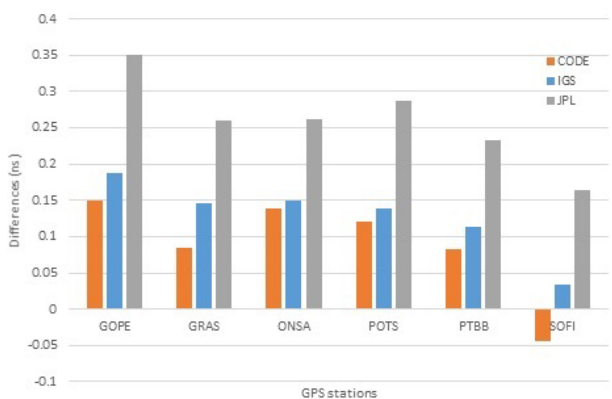
Figure 4. Mean differences between receiver DCB values estimated by MSDCBE and those released by CODE, JPL, and IGS combined from 1 to 31 January 2010.